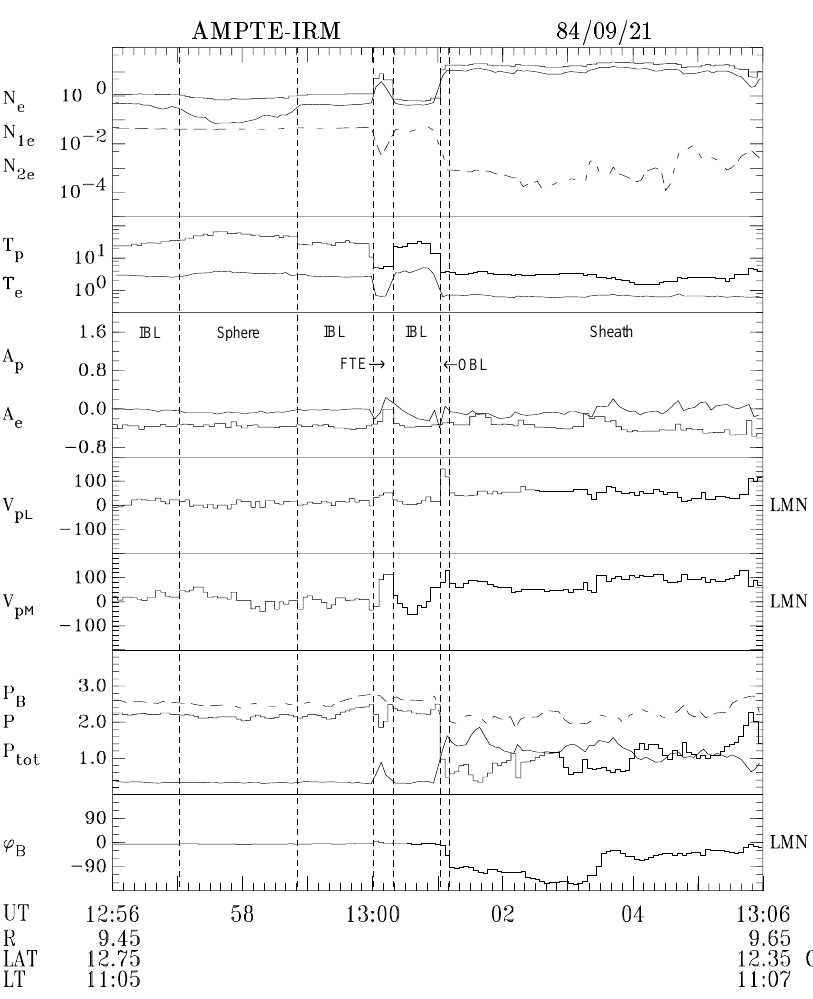
Fig. 1. Overview of the magnetopause pass on 21 September 1984. The upper panel shows the total (15eV–30keV) electron density, N e (histogram line), in cm − 3 and the partial densities, N 1 e (solid line) and N 2 e (dashed line), of electrons in the energy ranges 60eV– 1.8keV and 1.8keV–30keV, respec- tively. In the next two panels, the pro- ton and electron temperatures, T p (his- togram line) and T e (solid line), in 10 6 K and the respective anisotropies, A p = T p /T p ⊥ − 1 (histogram line) k /T e ⊥ − 1 (solid line), are and A e = T e k given. The next two panels present the components V pL and V pM of the pro- ton bulk velocity in km/s. V pL and V pM refer to the boundary normal coordinate system. In the sixth panel, the magnetic pressure, P B (histogram line), plasma pressure, P = N p KT p + N e KT e (solid line), and total pressure, P tot = P B + P (dashed line), in nPa are shown. The last panel gives the angle ϕ B the mag- netic field makes with the L axis in the LM plane of the boundary normal co- ordinate system. Vertical dashed lines indicate boundaries separating different plasma